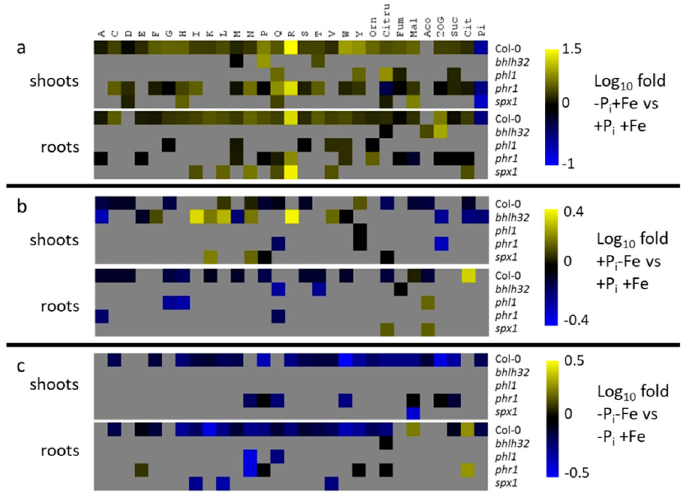
Figure 7. Metabolite changes in shoots (upper panels) and roots (lower panels) of Col-0 plants and mutants with impaired expression of P i deficiency response regulators. ( a ) response to P i deficiency in the presence of Fe ( − Pi+Fe vs. +P i +Fe); ( b ) response to Fe deficiency in the presence of P i (+P i − Fe vs. +P i +Fe); ( c ) response to combined P i and Fe deficiency compared to P i deficiency ( − Pi − Fe vs. − Pi+Fe). After an initial growth period of five days on nutrient sufficient conditions (+P i +Fe), seedlings were transferred to the indicated conditions and allowed to grow for an additional six days before harvest. +P i : 500 µM, − Pi: 5 µM, +Fe: 50 µM, − Fe: no Fe added. The log 10 fold changes are color coded. For Col-0, only changes at p ≤ 0.05 (Student´s t -test, two tailed, equal variances) are color coded. For the mutants, changes are color coded, if the metabolic response was different compared to the WT response at p ≤ 0.05 (two way ANOVA, n ≥ 8). Grey boxes indicate no change in metabolite concentrations in Col-0 by the respective treatment, or no difference in the metabolic response to the respective treatments between mutants and WT. Orn: ornithine; Citru: citrulline; Fum: fumarate; Mal: malate; Aco: aconitate; 2OG: 2-oxoglutarate; Suc: succinate; Cit: citrate. Heat maps have been generated according to the data shown in Datasets S7 and S8.